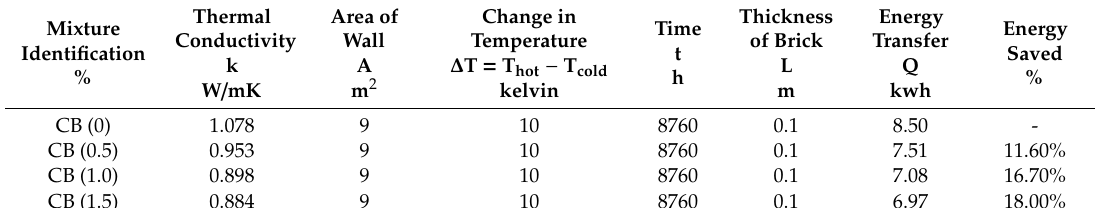
Table 4. Energy savings between a fired clay brick wall with 0% CB content and 0.5%, 1%, 1.5%, and 2% CB content.